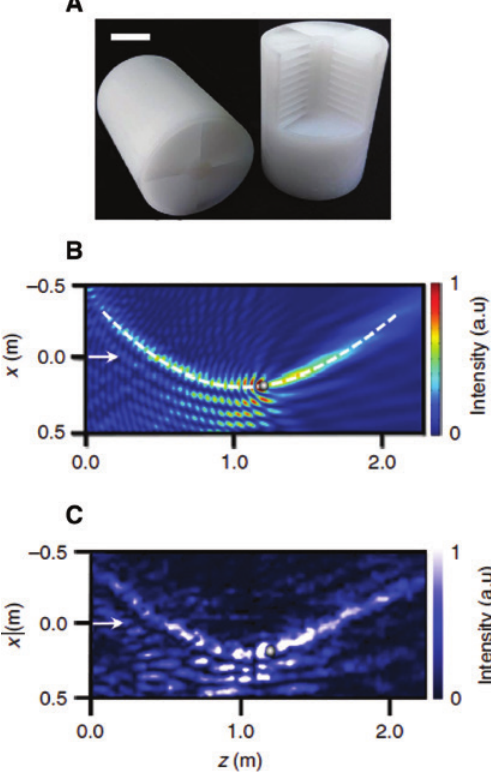
Figure 9: Helical-structured metasurface for generating self- accelerating beam. (A) Fabricated helical-structured unit cell (photo). (B) The